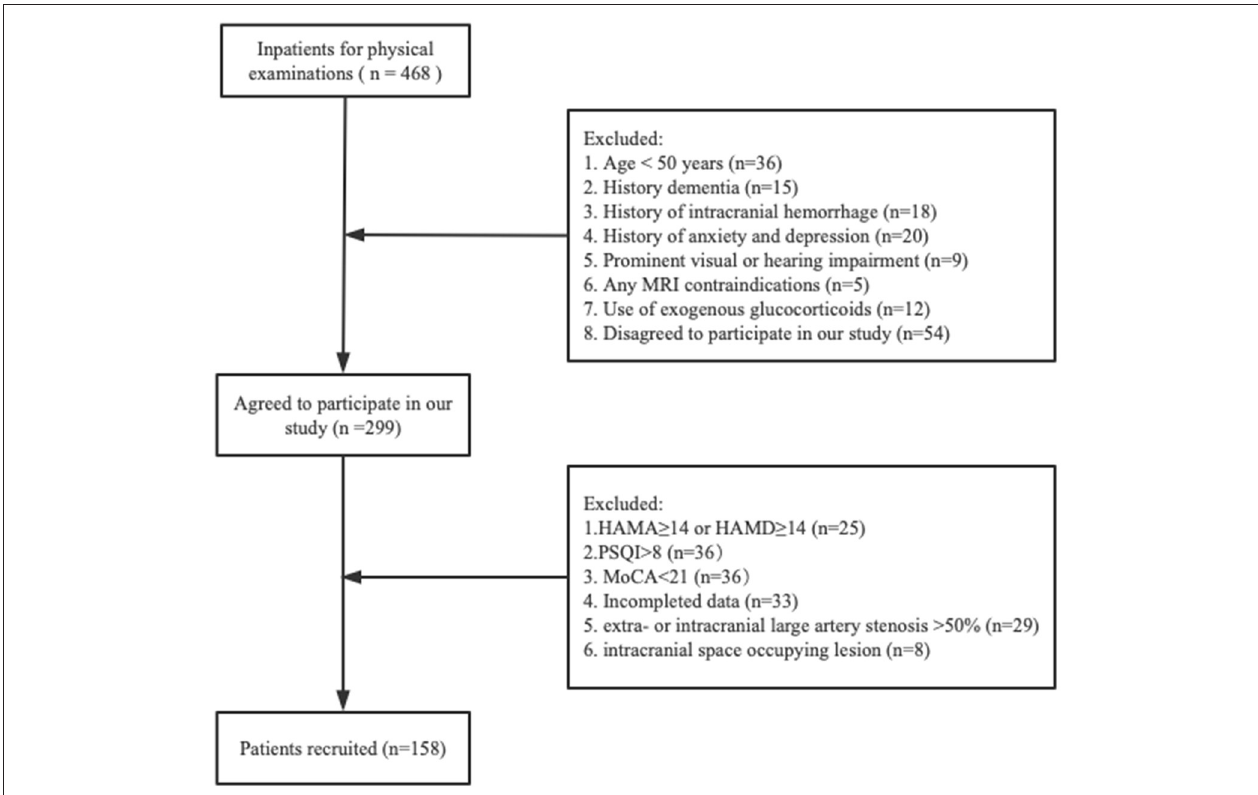
FIGURE 1 | Flowchart of participants selection. HAMA, Hamilton Anxiety Scale; HAMD, Hamilton Depression Scale; PSQI, Pittsburgh Sleep Quality Index; MoCA, Montreal Cognitive Assessment.